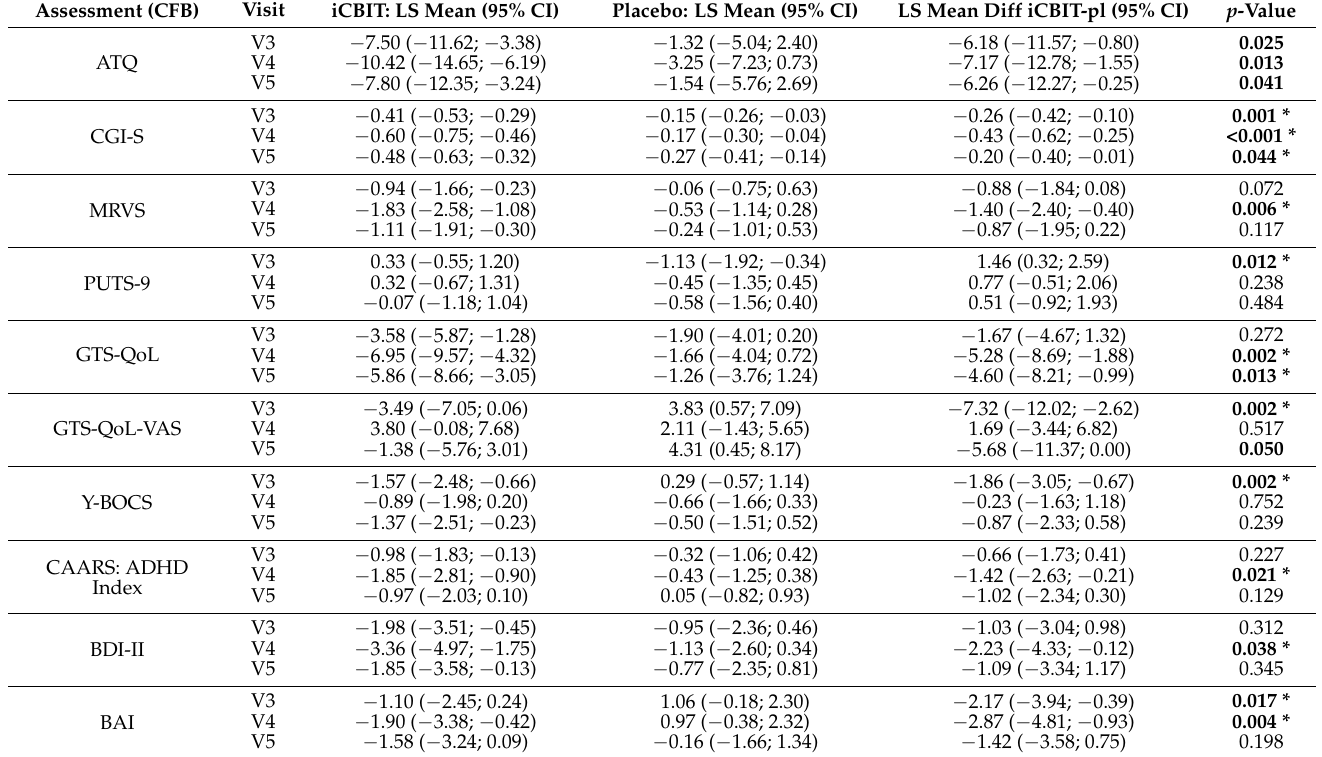
Table 4. Comparison of further assessments for tics, comorbidities, and quality of life between iCBIT and placebo at 1 week after end of treatment (V3, primary endpoint) and follow-up visits (V4,